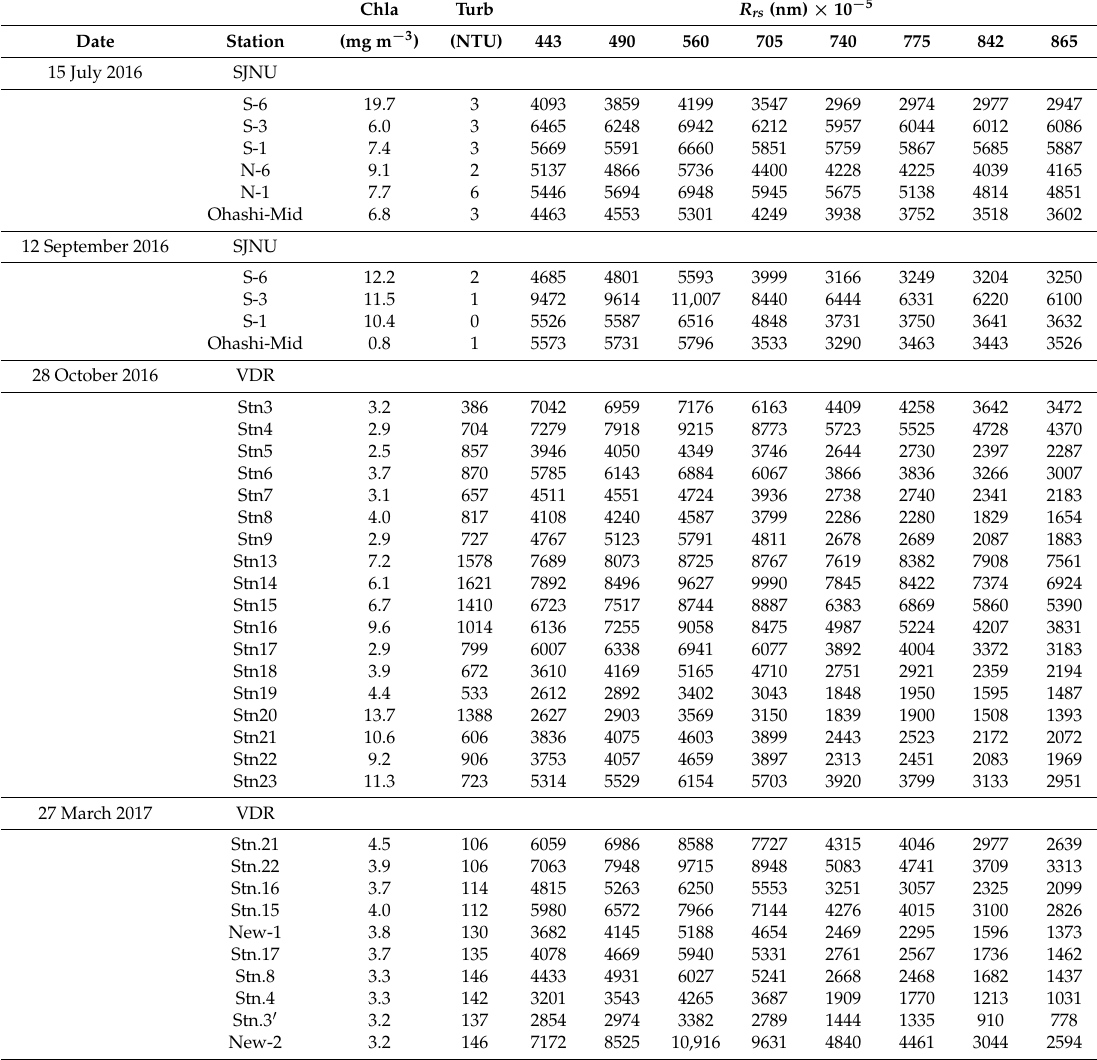
Table A1. The summary of dataset used in this study. The R rs is shown for the Sentinel-2 MSI band